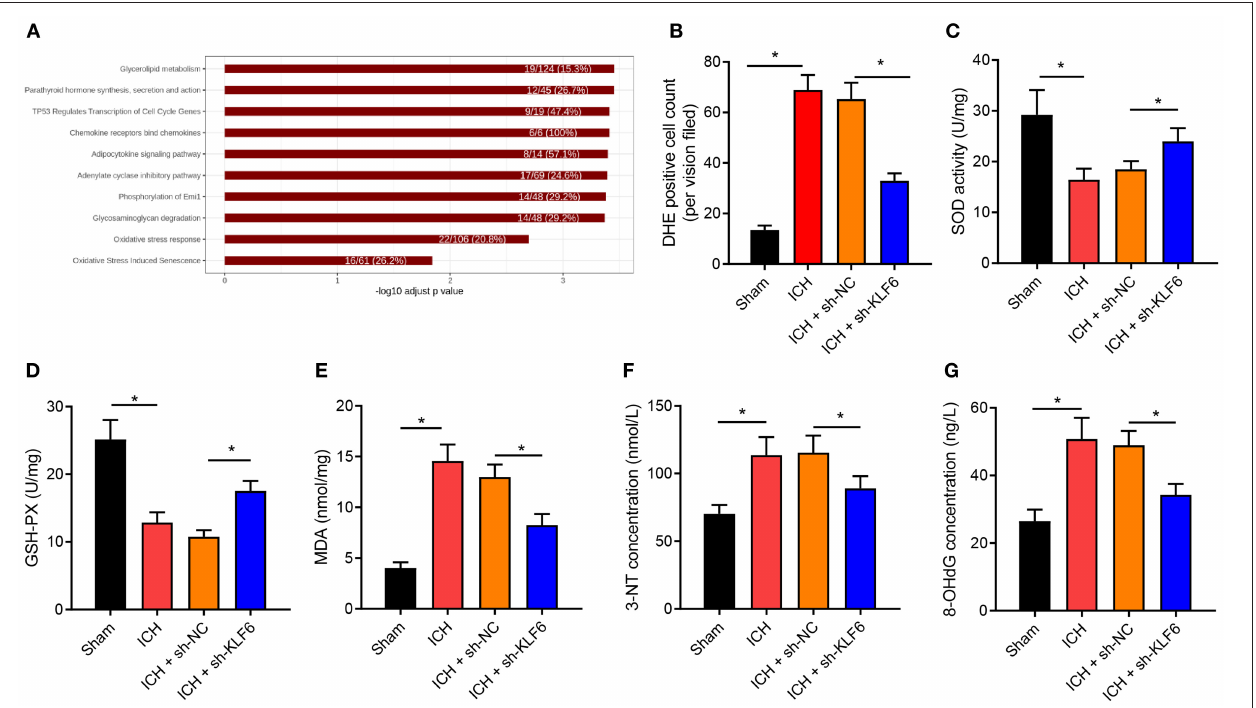
FIGURE 4 | KLF6 silencing represses oxidative stress in the hippocampus of ICH rats. (A) Kobas v3.0 enrichment analysis of KLF6 regulation pathway in ICH-related microarray GSE149317. (B) Reactive oxygen in the hippocampus of rats 72h after ICH modeling and infection with sh-KLF6 detected by DHE staining. (C) SOD activity in hippocampus of ICH rats after different infection. (D) GSH-Px activity in hippocampus of ICH rats after different infection. (E) MDA level in hippocampus of ICH rats after different infection. (F) 3-NT concentration changes in hippocampus of ICH rats after different infection. (G) 8-OHdG concentration changes in hippocampus of ICH rats after different infection. n = 6 rats/group. * p < 0.05. The measurement data were expressed as mean ± standard deviation. Comparisons between two groups were analyzed using unpaired t -test, and comparisons among multiple groups were tested by one-way ANOVA followed by Dunnett post-hoc